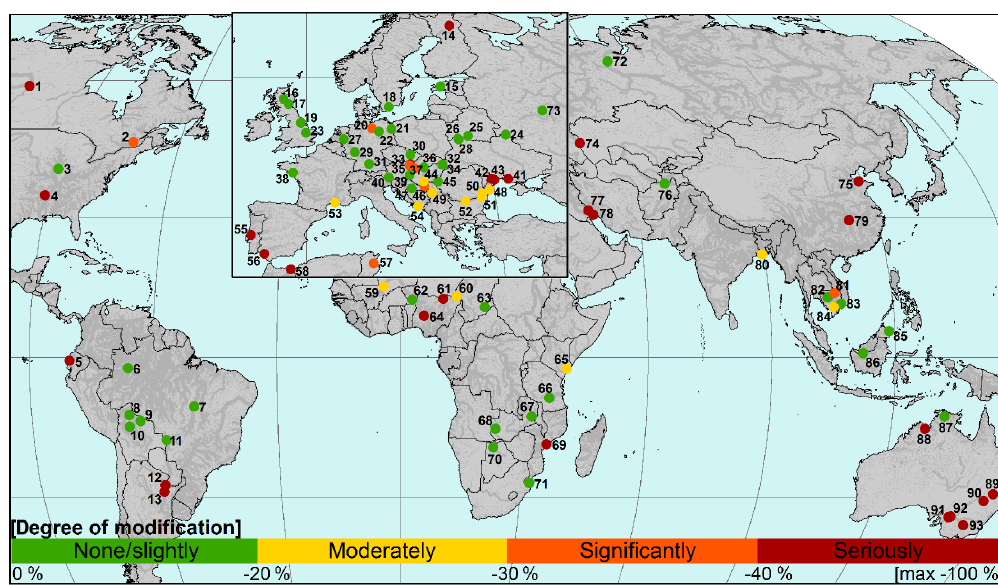
Figure 2. Global map of overbank flow alterations for selected riparian wetlands of international importance (nos. 1–93) as a consequence of current water resource